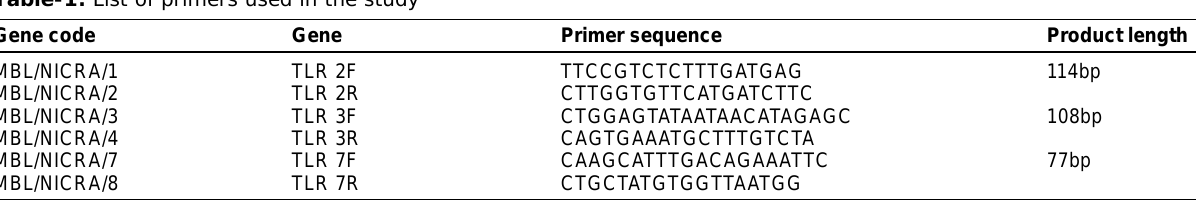
Table-1: List of primers used in the study Gene